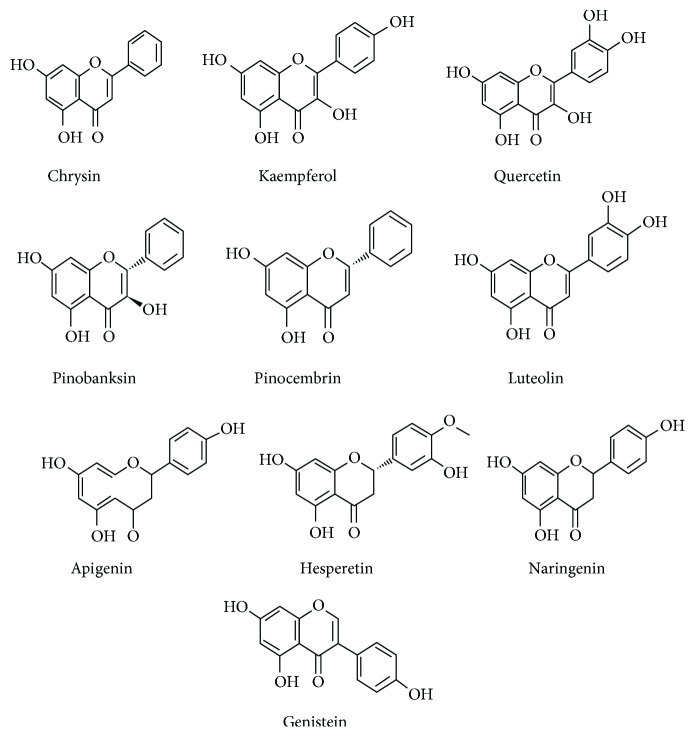
Chemical structures of flavonoids in honey [17].